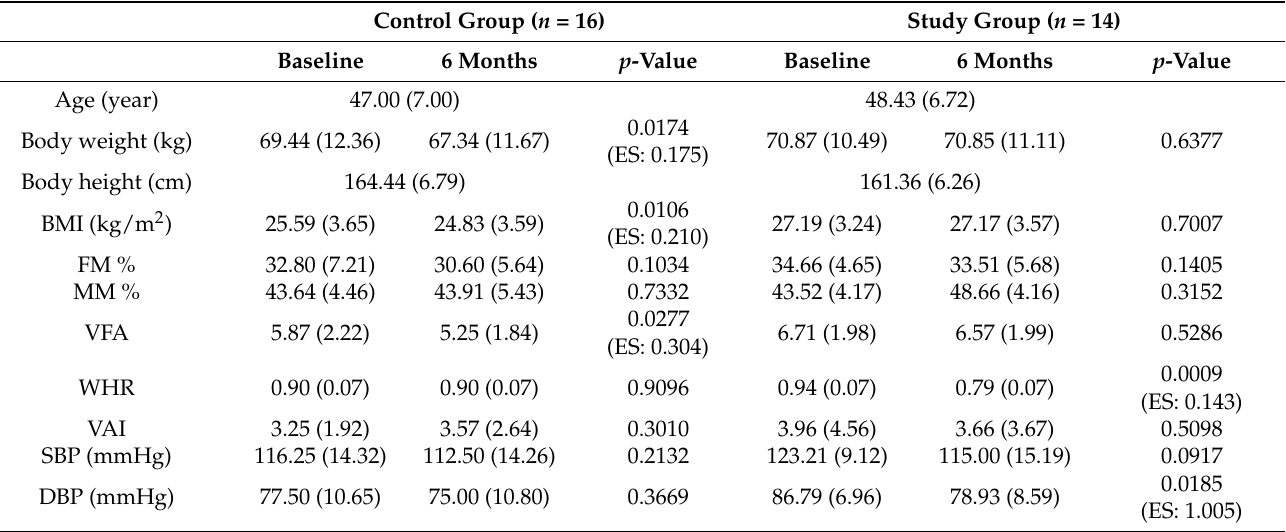
Table 1. Values of anthropometric parameters, blood pressure values and VAI for the study and control groups on the first and second testing